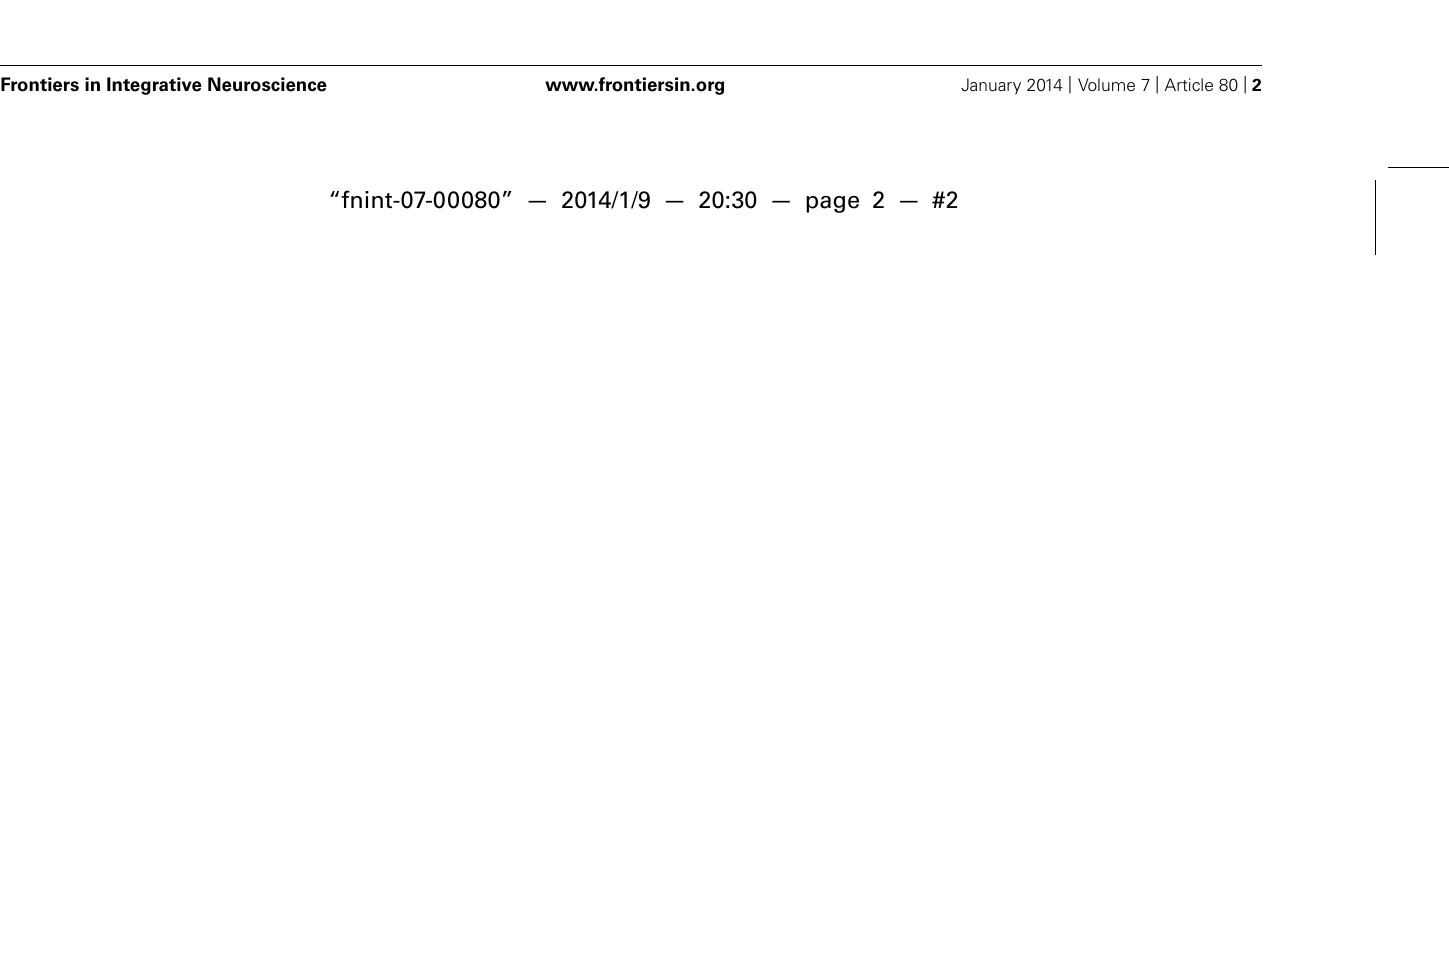
Symbols are as follow: ( + ) Indicates that the marker is present; ( − ) indicates that the marker is absent; ( + / − ) indicates a decrease in marker expression and; ( ++ ) indicates that the marker is over